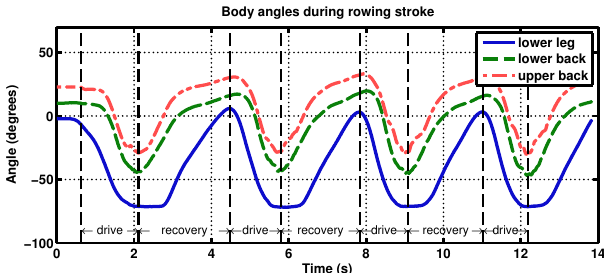
Figure 2: Example of the sensor angles during row- ing at 20 strokes per